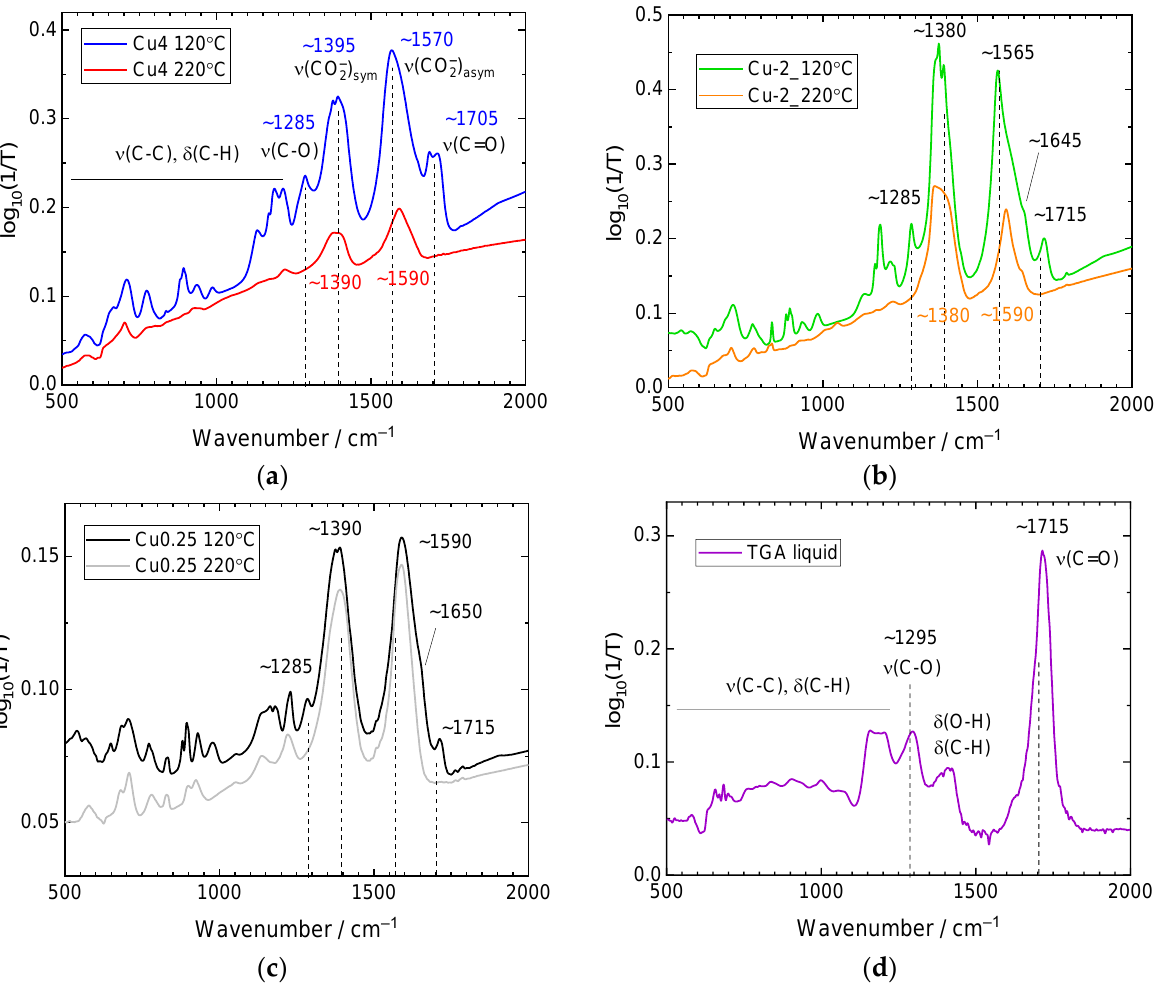
Figure 7. Mid-FTIR spectra of the initial and annealed CZTS NC films with the nominal contents Cu 4 ( a ), Cu 2 ( b ), and Cu 0.25 ( c ). The spectrum of the pure ligand (TGA) is shown for comparison ( d ). Similar bands are detected in all CZTS samples before annealing. For a deprotonated COO – group, the electron density between C-O and C=O is delocalized, making these bonds indistinguishable and contributing to the FTIR spectrum with symmetric (lower wavenumbers) and asymmetric (higher wavenumbers) vibrations of all three atoms [63]. The frequencies of these two vibrations and the splitting ∆ between them partially depend on the heavy atom (metal ion) mass, but the type of bonding has an even greater influence on the metal ion, determined by the size, charge, and coordination abilities of the latter. Comparing our spectra with the literature data on Cu-, Zn-, and Sn-carboxylates [63,64], we can conclude that, before annealing, the Cu 4 and Cu 2 samples reveal a chelate bonding of thioglycolate to Zn and Cu (the ν (COO – ) sym / ν (COO – ) asym doublet at ~1395/~1570 cm − 1 , respectively). The Cu 0.25 sample demonstrates a bridging type of COO – bonding to Cu and Zn (~1395/1590 cm − 1 ). The TGA derivative in the sample Cu 2 is additionally bonded to Sn (~1395/1645 cm − 1 ). After annealing at 220 ◦ C, the bonds between COO – and Cu/Zn are predominantly bridging, while other bonding types are suppressed or disappear. Another effect of annealing is the elimination of the protonated COOH groups, most likely due